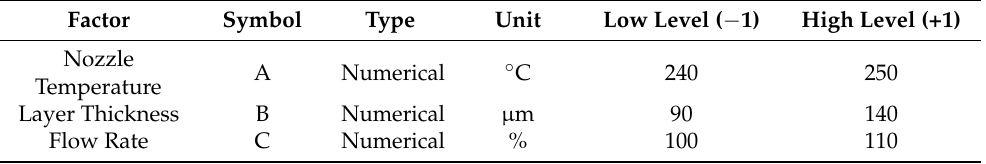
Table 2. Printing settings varied in accordance with the experimental plan.